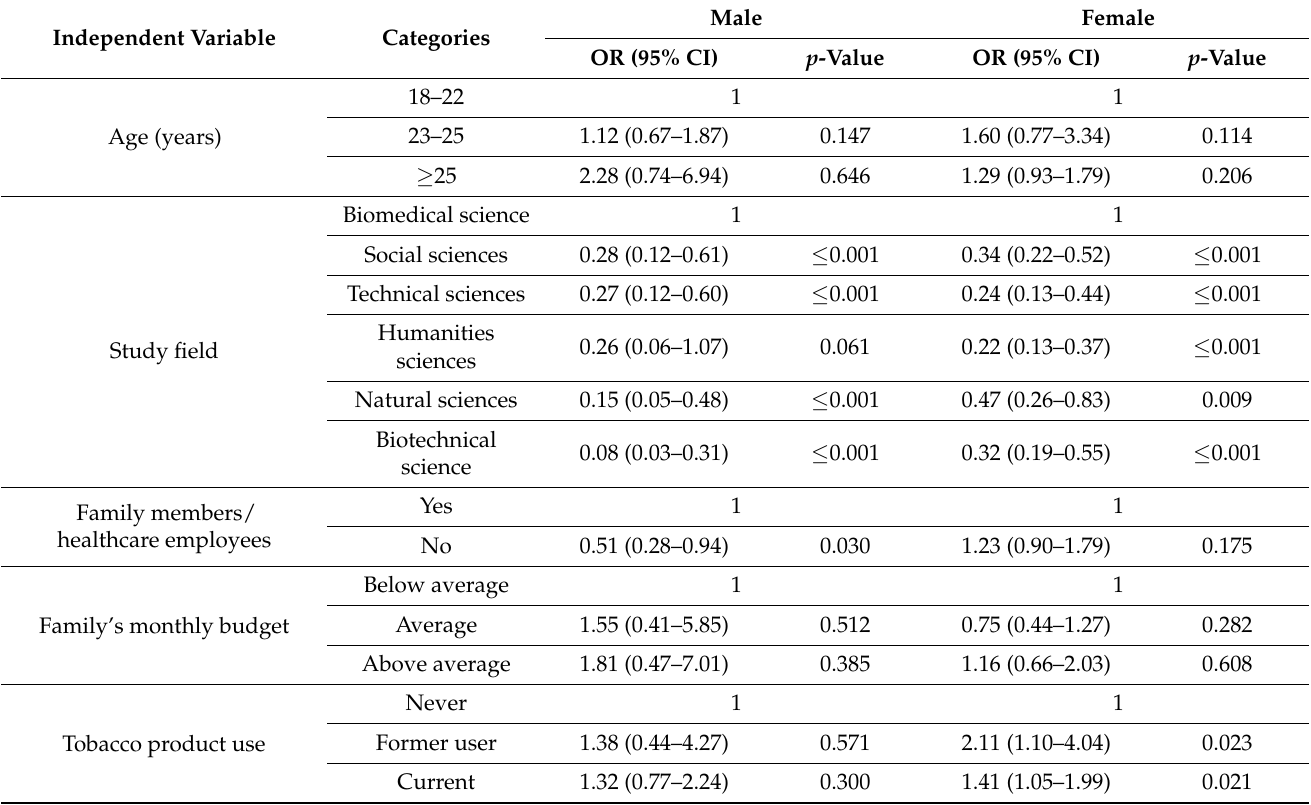
Table 6. Gender-specific generalized linear model regression for estimating the odds ratio and 95% confidence interval for knowledge about tobacco products and their harmful